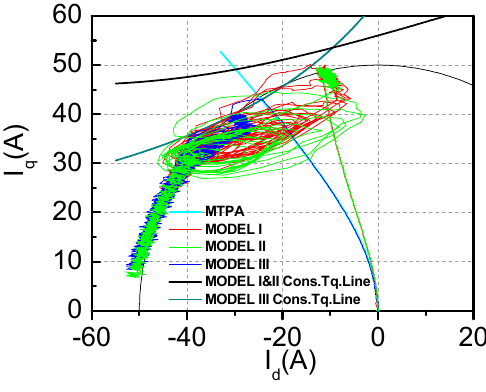
MODEL I&II Cons.Tq.Line MODEL III Cons.Tq.Line